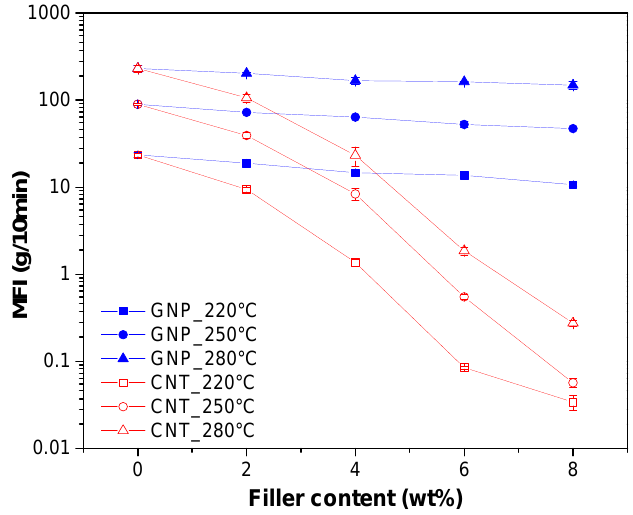
Figure 3. Melt flow index of ABS/graphene (full symbols) and ABS/CNT (open symbols) nanocomposites at selected temperatures and nanofiller fractions. Table 1. Melt flow index (10 Kg, various temperatures) and activation energy for neat ABS and nanocomposites with graphene or carbon nanotubes.